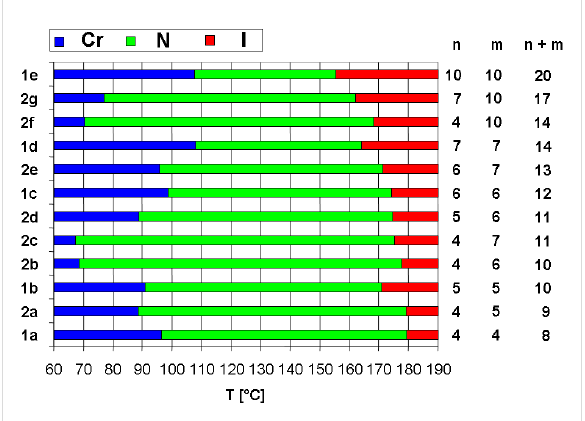
Figure 4: Comparison of the thermal behaviour of symmetric and non- symmetric V-shaped molecules. The molecules are ordered from the bottom to the top by increasing total number of spacer CH 2 groups ( n + m